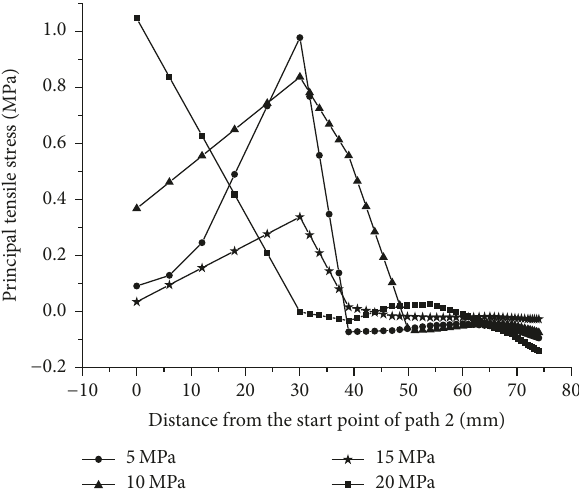
Figure 23: Comparison of the principal tensile stress generated along path 2 from corrosion-induced expansion when the displace- ment resulting from corrosion-induced expansion reaches 0.01 mm.